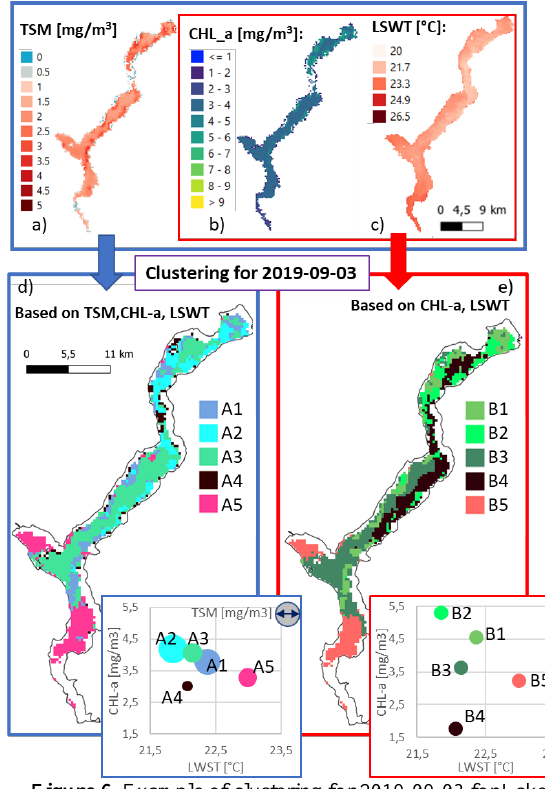
Figure 6. Example of clustering for 2019-09-03 for Lake Maggiore, by considering TSM, CHL-a, LWST maps (a, b, c) in d) or by considering just CHL-a, LWST maps, in e). Clusters are here visualized with a RGB composition based on the three WQPs: Red is linked to LWST, Green to CHL-a, Blue to TSM clusters mean values. The graphs show both the clusters analysed for their representative values, where TSM is represented by the circle